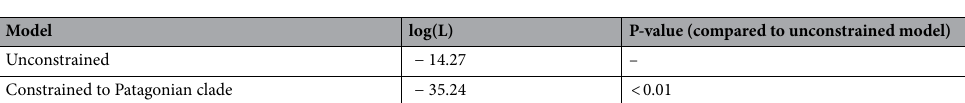
Figure 3. Results of analysis to infer the position of the type material of Xylodon australis using locate.yeti function. ( a ) Position of the type material. ( b , c ) Branch score and quadratic paths distances from the original molecular tree. All plots were generated using R Core Team v3.6.1 (https ://www.R-proje ct.org/).